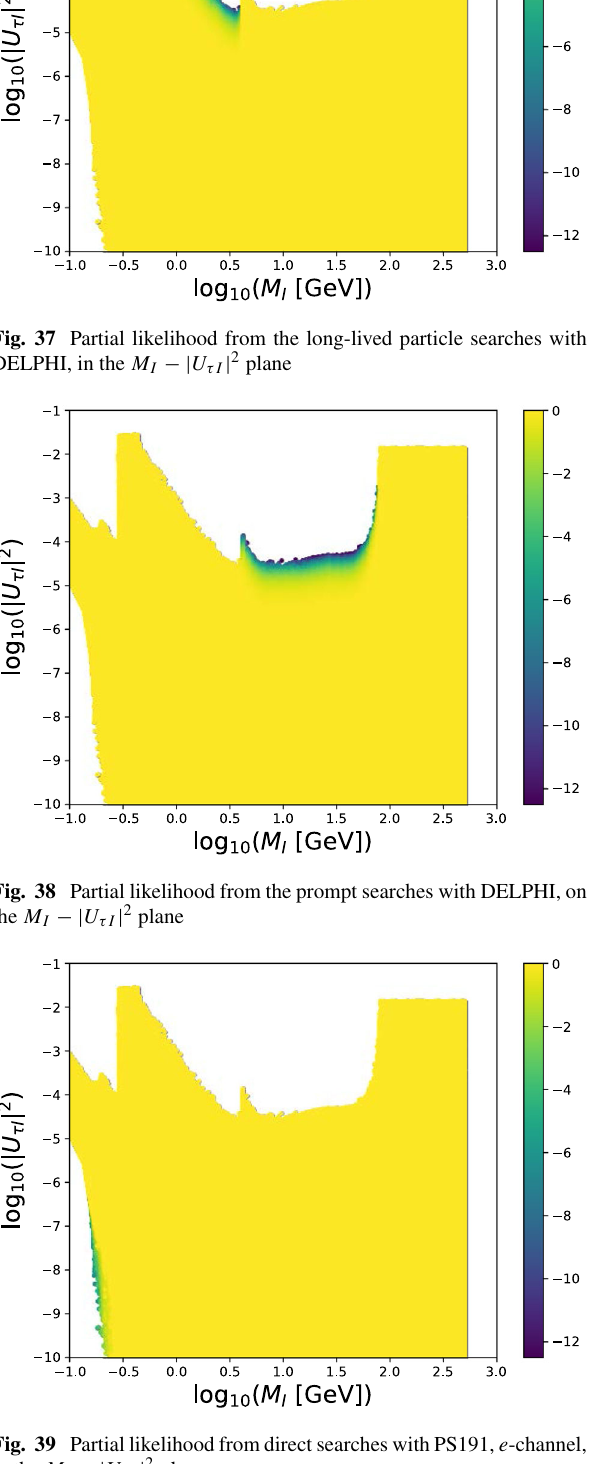
Fig. 39 Partial likelihood from direct searches with PS191, e -channel, in the M I − | U τ I | 2 plane